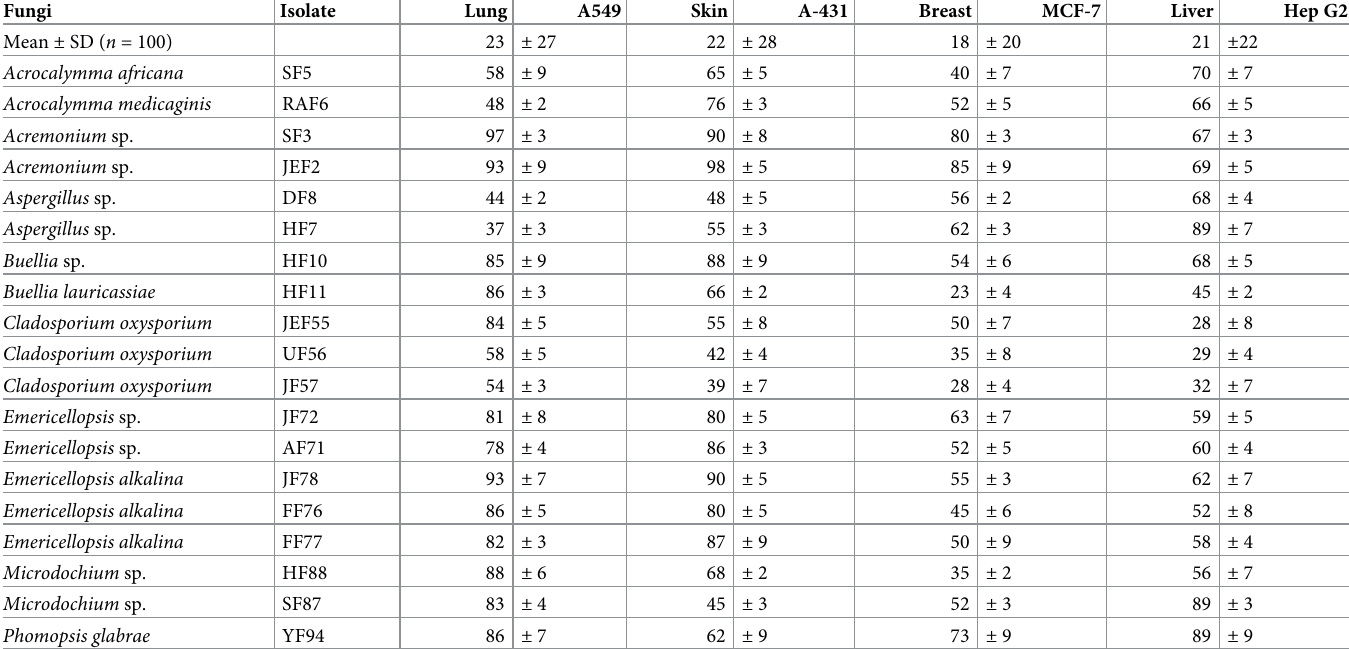
Table 2. Activity (% of inhibition) against four cancer types (mean ± SD, n = 3) of the top 19 marine fungal isolates in comparison to the mean of all 100 marine fungal